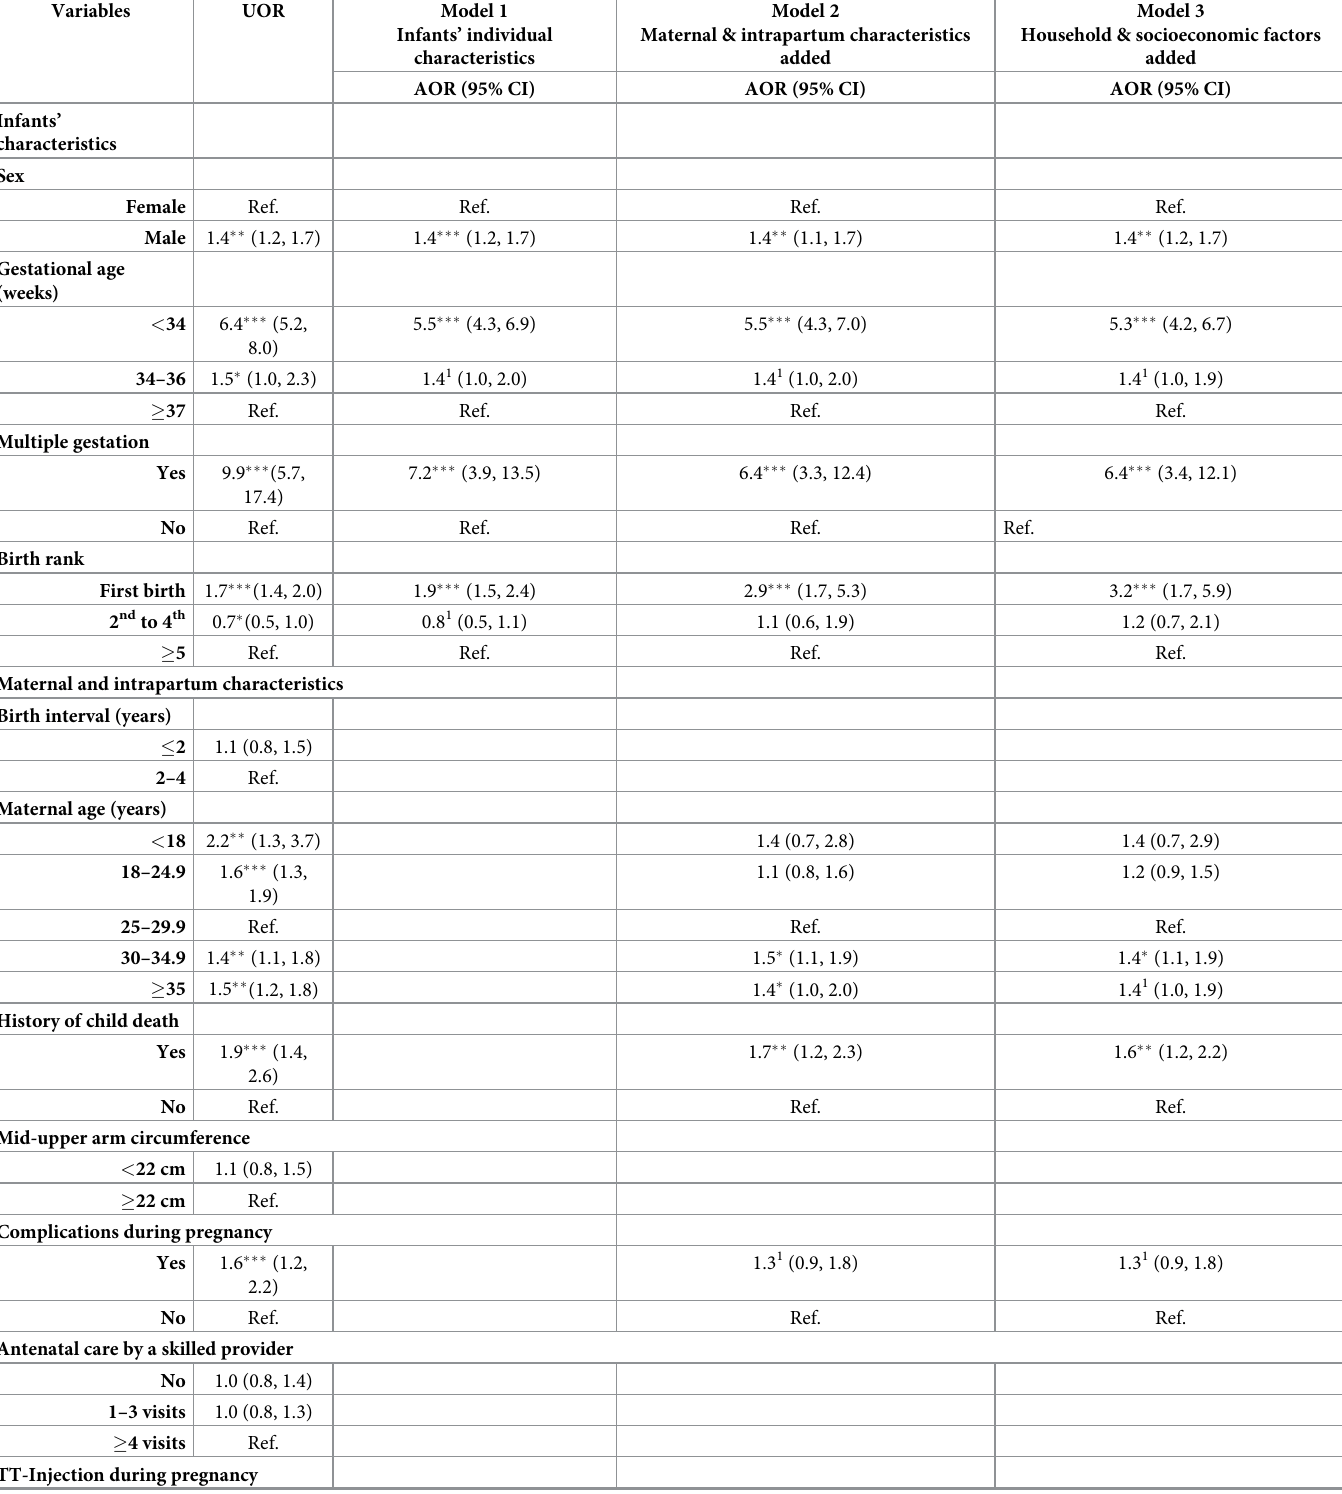
Table 2. Multivariable models for potential risk factors for neonatal